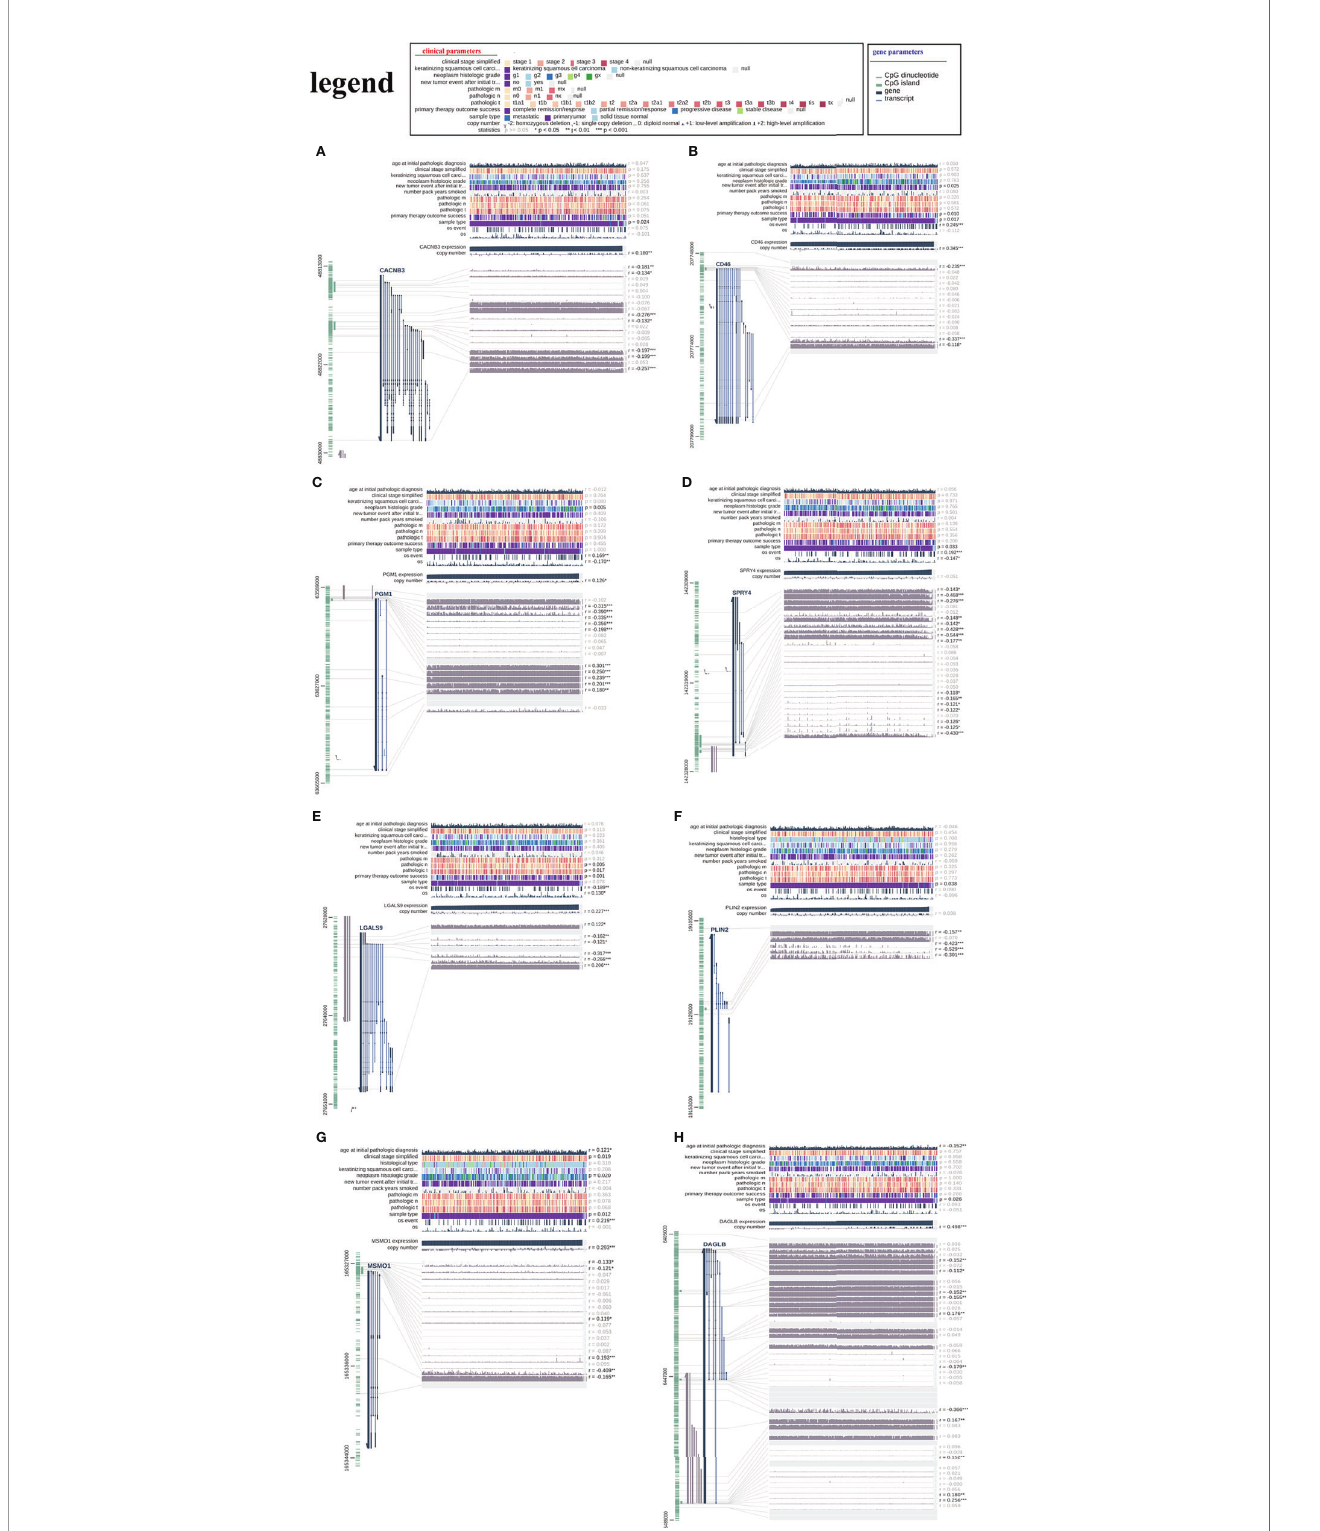
FIGURE 14 | The relationship between the risk signature and DNA methylation status. The visualization of the relationships between TCGA expression, DNA methylation and clinical data by MEXPRESS for (A) CACNB3, (B) CD46, (C) PGM1, (D) SPRY4, (E) LGALS9, (F) PLIN2, (G) MSMO1 and (H)